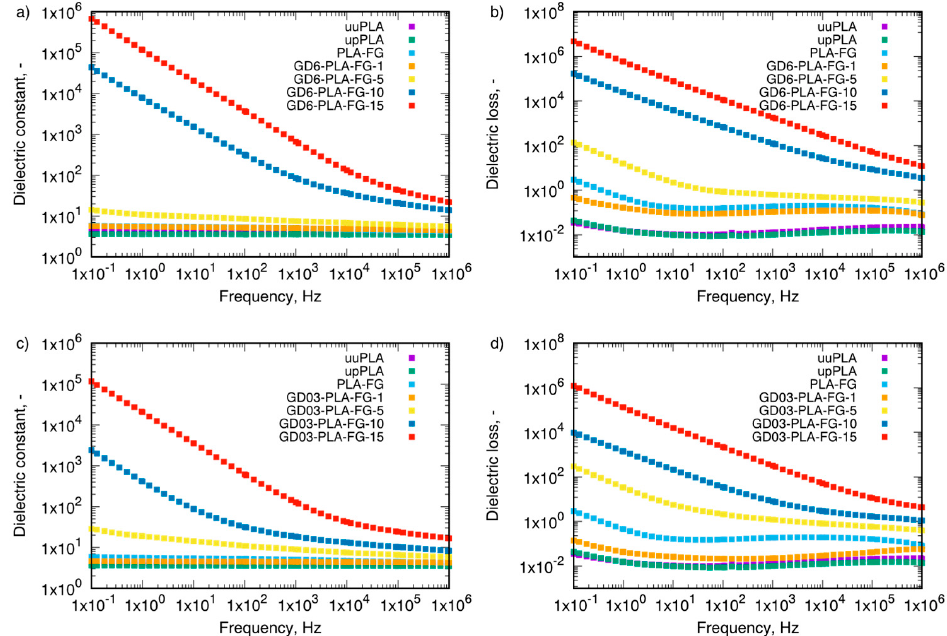
Figure 5. Dielectric constant of: ( a ) GD6-PLA-FG nanocompoites, ( c ) GD03-PLA-FG nanocomposite and dielectric loss ( b ) GD6-PLA-FG nanocomposites, ( d ) GD03-PLA-FG nanocomposites at 298.15 K. uuPLA—unfilled and unprocessed PLA, upPLA—unfilled and processed PLA, PLA-FG—PLA with plasticizer and compatibilizer, GD6—graphite/diamond mixture with 6 wt.% ash content, GD03—graphite/diamond mixture with 0.3 wt% ash content, numbers—wt.% of filler (GD6, GD03).